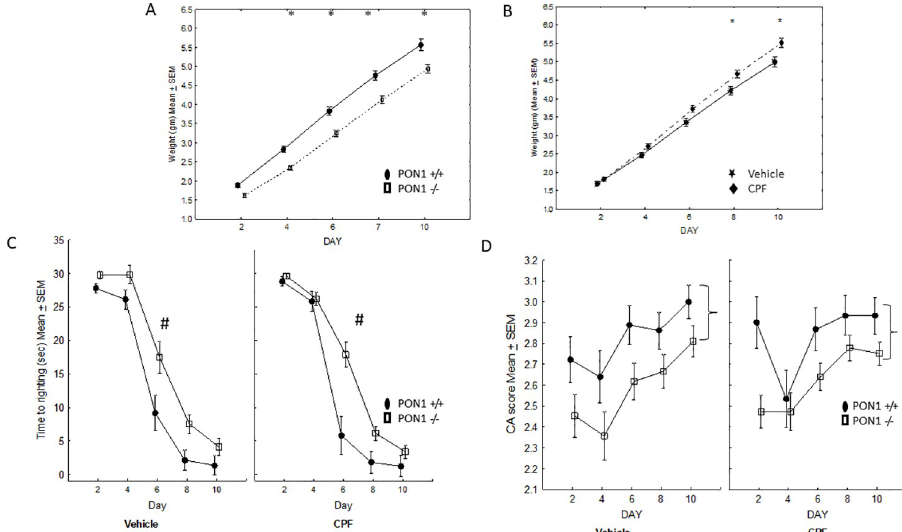
� p < 0.05. C. Time until completion of righting reflex. # Day 6 PON1 -/- were significantly slower than PON1 +/+ mice, p < 0.00001. D. Cliff Avoidance reflex score.} indicates main effect of genotype showing lower scores in the PON1 -/- mice. The number of mouse pups per group is: PON1 +/+ –Vehicle = 6 M and 6 F; PON1 +/+ —CPF = 5 M and 5 F. PON1 -/- Vehicle = 7 M and 7 F; PON1 -/- CPF = 12 M and 12 F.